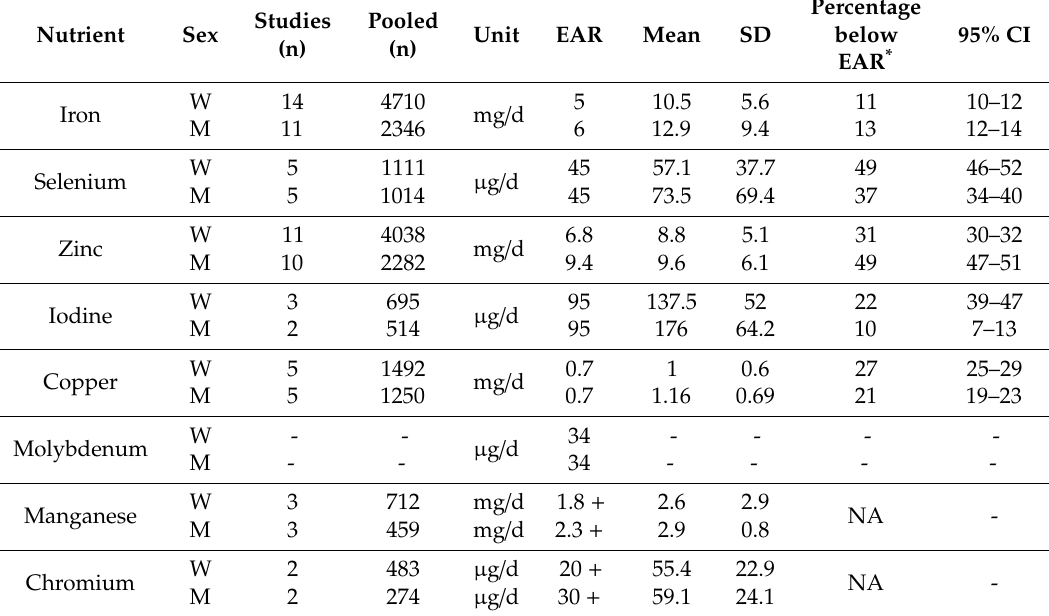
Table 8. Daily trace mineral intake and percentage of inadequate intakes of older adults living in the